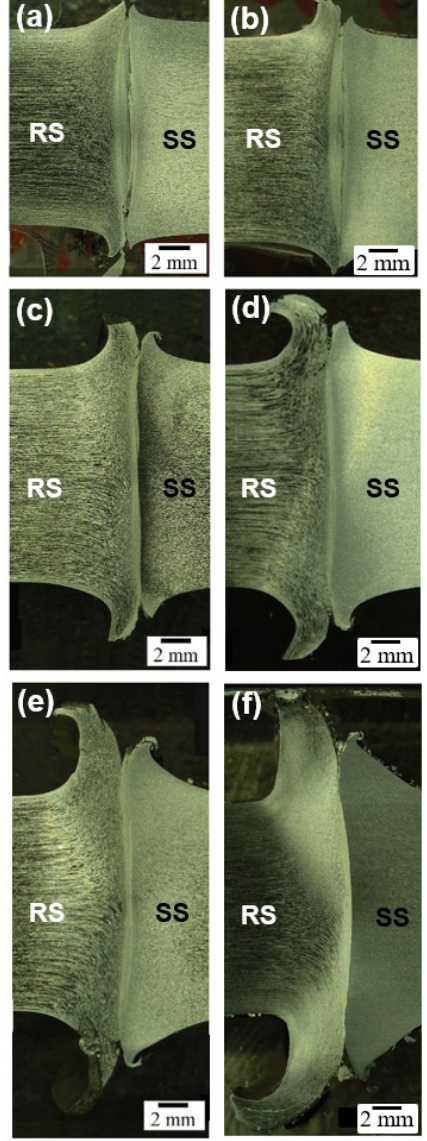
Figure 8. Macrostructures of the dissimilar AA7075/AA5083 rotary friction welded joints at various rotational speeds: ( a ) 370 rpm, ( b ) 540 rpm, ( c ) 800 rpm, ( d ) 1200 rpm, ( e ) 1700 rpm and ( f ) 2500 rpm. Note: RS and SS are notations for rotary-side and stationary-side respectively.